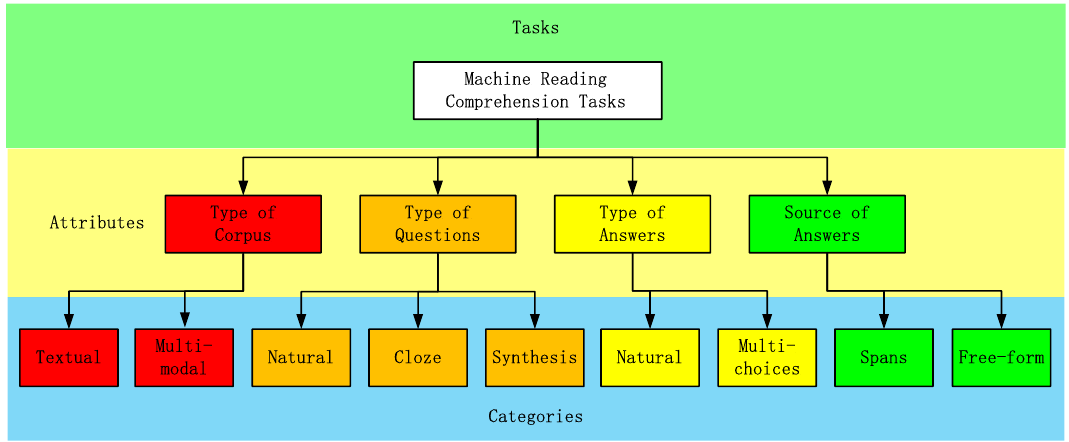
Figure 9. A new classification method of machine reading comprehension